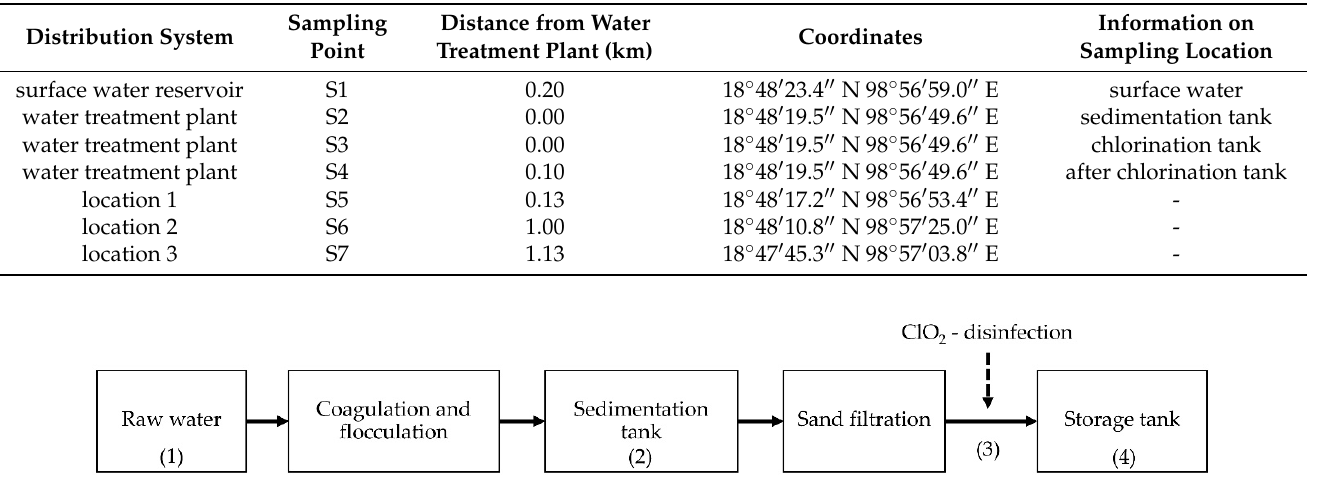
Table 1. Information on sampling locations. Figure 1. Sampling locations [26].